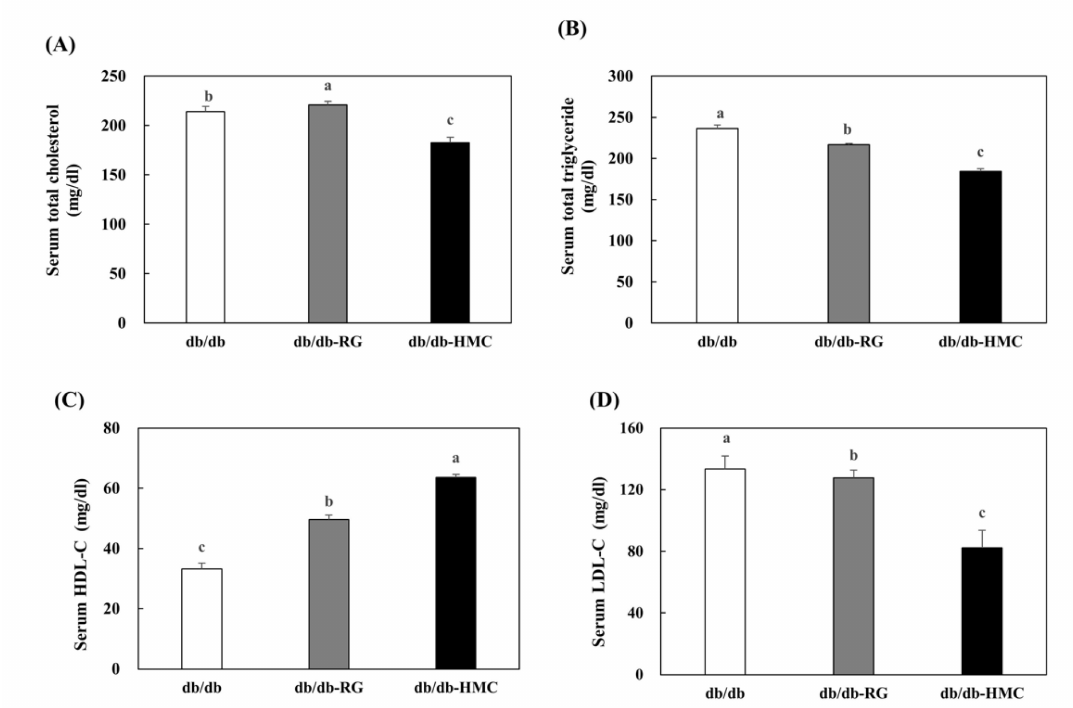
Figure 4. The effects of HMC administration on the levels of serum lipid in C57bL/ksj-db/db mice. ( A ) Serum total cholesterol level, ( B ) Serum total triglyceride level, ( C ) Serum HDL-cholesterol level, and ( D ) Serum LDL-cholesterol level. Mean ± SD ( n = 8). a–c The mean values that are not indicated by a common letter are significantly different among the groups ( p < 0.05) according to Duncan’s multiple range test. SD, standard deviation. db/db, db/db-RG (5 mg/kg BW per day) and db/db-HMC group (30 mg/kg BW per